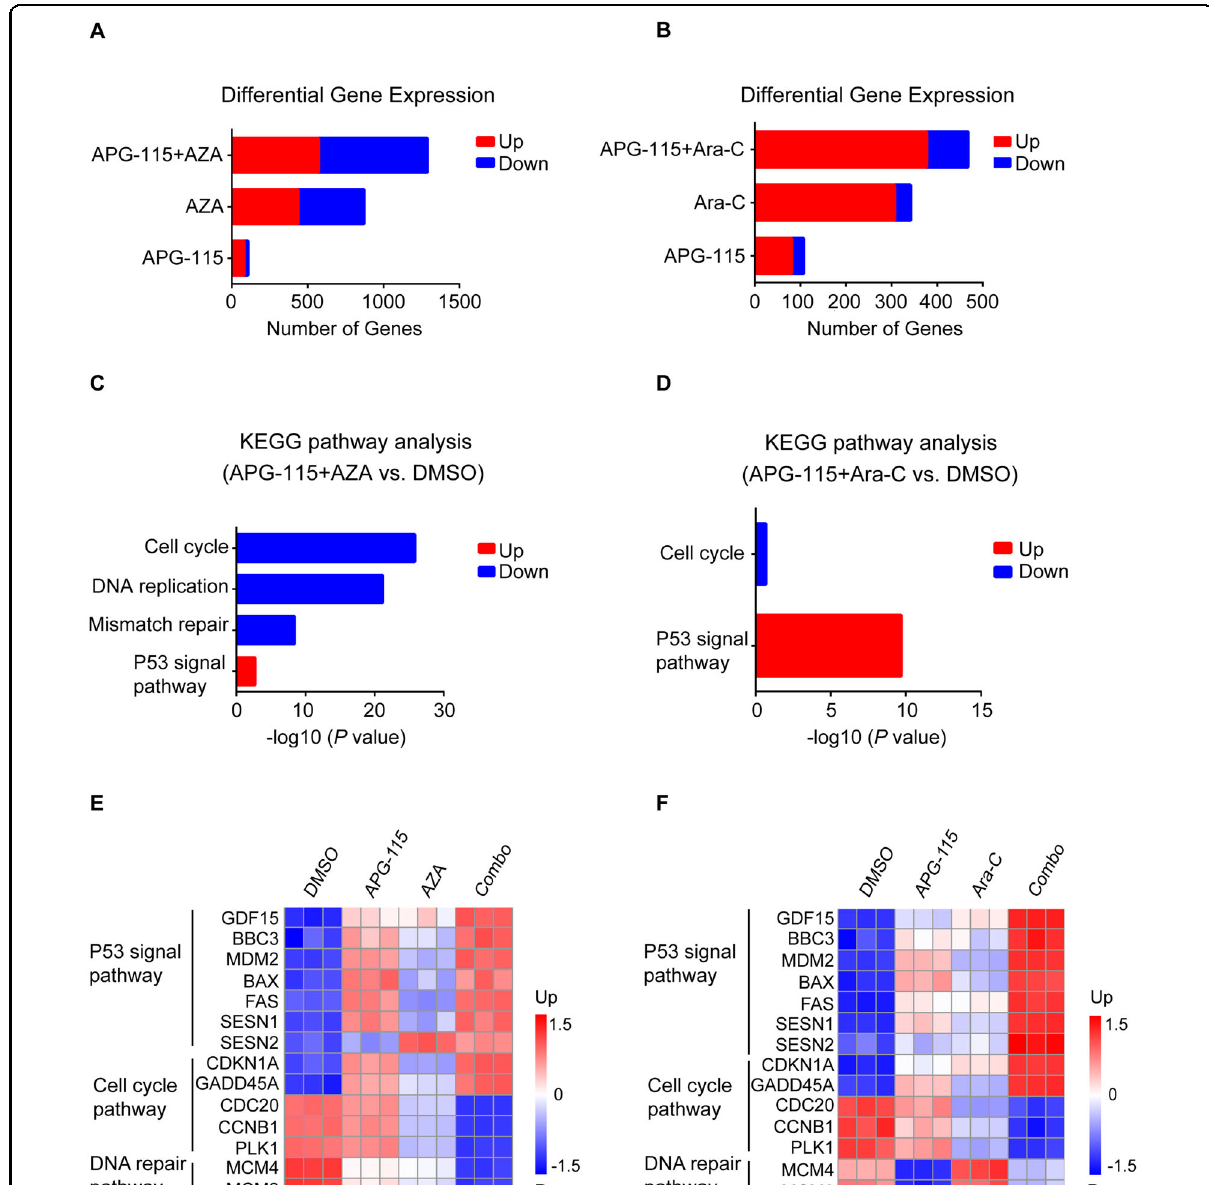
Fig. 5 RNA sequence analysis of MOLM-13 cells treated with APG-115, AZA, Ara-C, or combinations as indicated for 24 h. MOLM-13 cells treated with APG-115 (40 nM), AZA (3 μ M), Ara-C (100 nM), alone or in combination for 24 h in triplicates. Cells were collected for RNAseq analysis after treatment. A , B Numbers of differentially expressed genes after each treatment. C , D The most signi fi cantly enriched biological processes upregulated or downregulated in response to combined treatments: both AZA and Ara-C together with APG-115 upregulated P53, while the APG- 115-AZA combination more markedly downregulated AML cell cycle, DNA replication, and mismatch repair. E , F Representative differentially expressed genes in response to APG-115, AZA, or Ara-C, alone or in combination. Combinations of APG-115 with either agent upregulated genes encoding the P53 pathway and downregulated those related to the cell cycle pathway, but only the APG-115-AZA combination markedly downregulated genes implicated in DNA repair. Expression levels are presented as normalized log 2 counts per million. BBC3 Bcl-2-binding component 3 gene, CCNB1 Cdc2-cyclin B1 gene, DMSO dimethylsulfoxide vehicle, CDC20 cell division cycle 20 gene, CDKN1A cyclin-dependent kinase inhibitor 1A gene, GADD45 growth arrest and DNA damage-inducible 45, GDF15 growth differentiation factor 15 gene, KEGG Kyoto Encyclopedia of Genes and Genomes, MCM2/4 minichromosome maintenance proteins 2/4 gene, PLK-1 serine/threonine-protein kinase (also termed Polo-like kinase 1) gene, SESN1/2 , sestrin 1 and 2 genes.